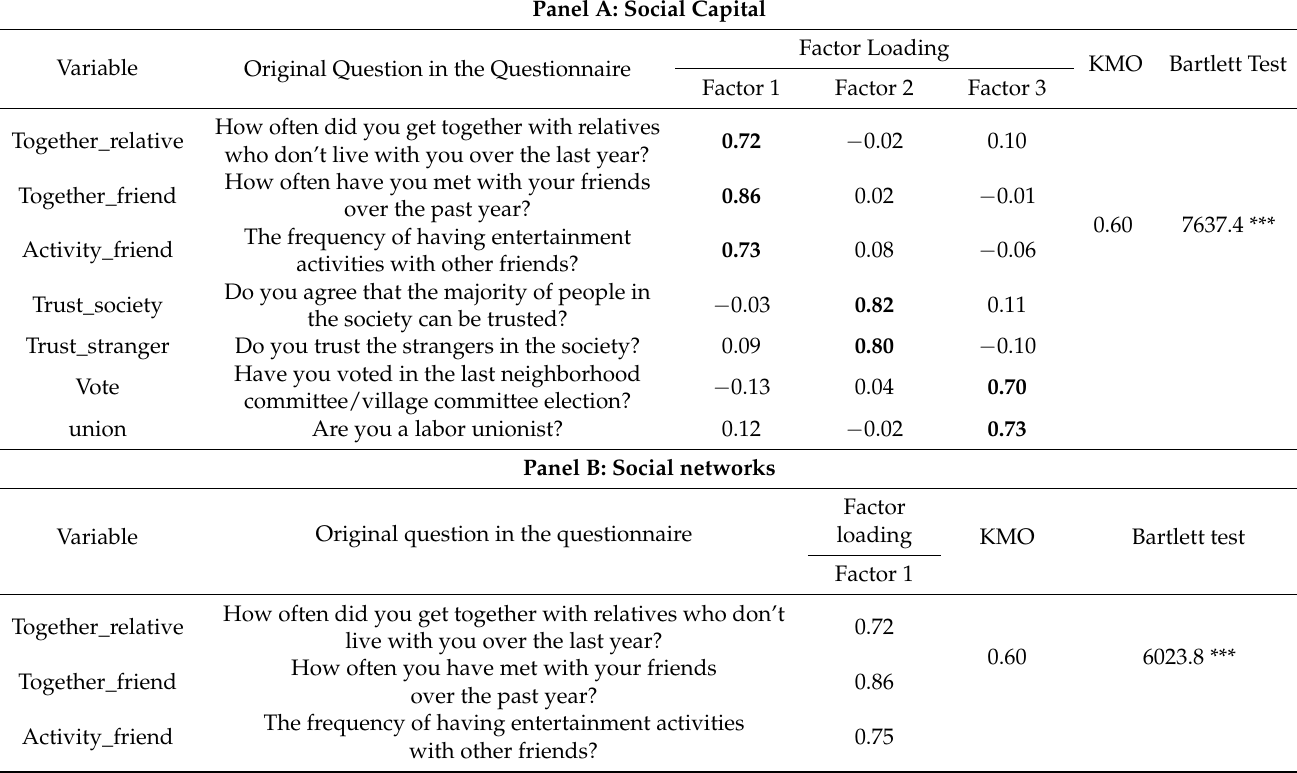
Table 1. The results of factor analysis. Panel A: Social